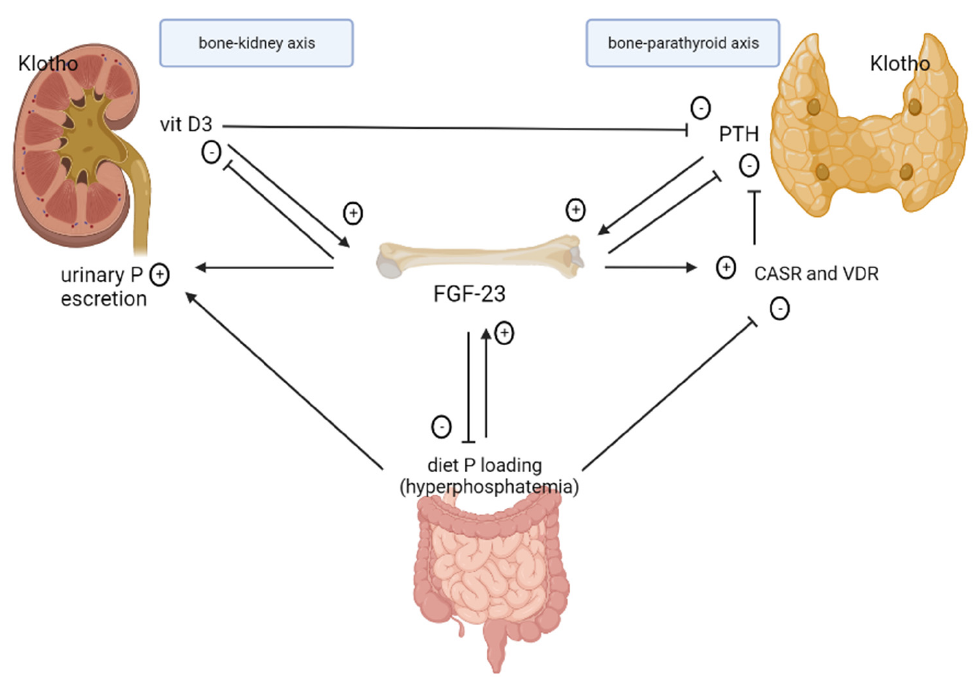
Figure 1. The interplay among FGF-23, PTH, vitamin D3, and phosphorus in CKD. Secretion of FGF-23 is stimulated by increased levels of PTH, 1,25(OH)D3 and phosphorus from diet loading. On the other side, FGF-23 inhibits PTH secretion, decreases levels of 1,25(OH)D3, reduces intestinal absorption of alimentar phosphorus, inhibits phosphorus reabsorption in the proximal tubule leading to increased urinary excretion. Furthermore, 1,25(OH)D3 suppresses PTH, and hyperphosphatemia reduces CASR sensibility, directly affecting PTH synthesis.